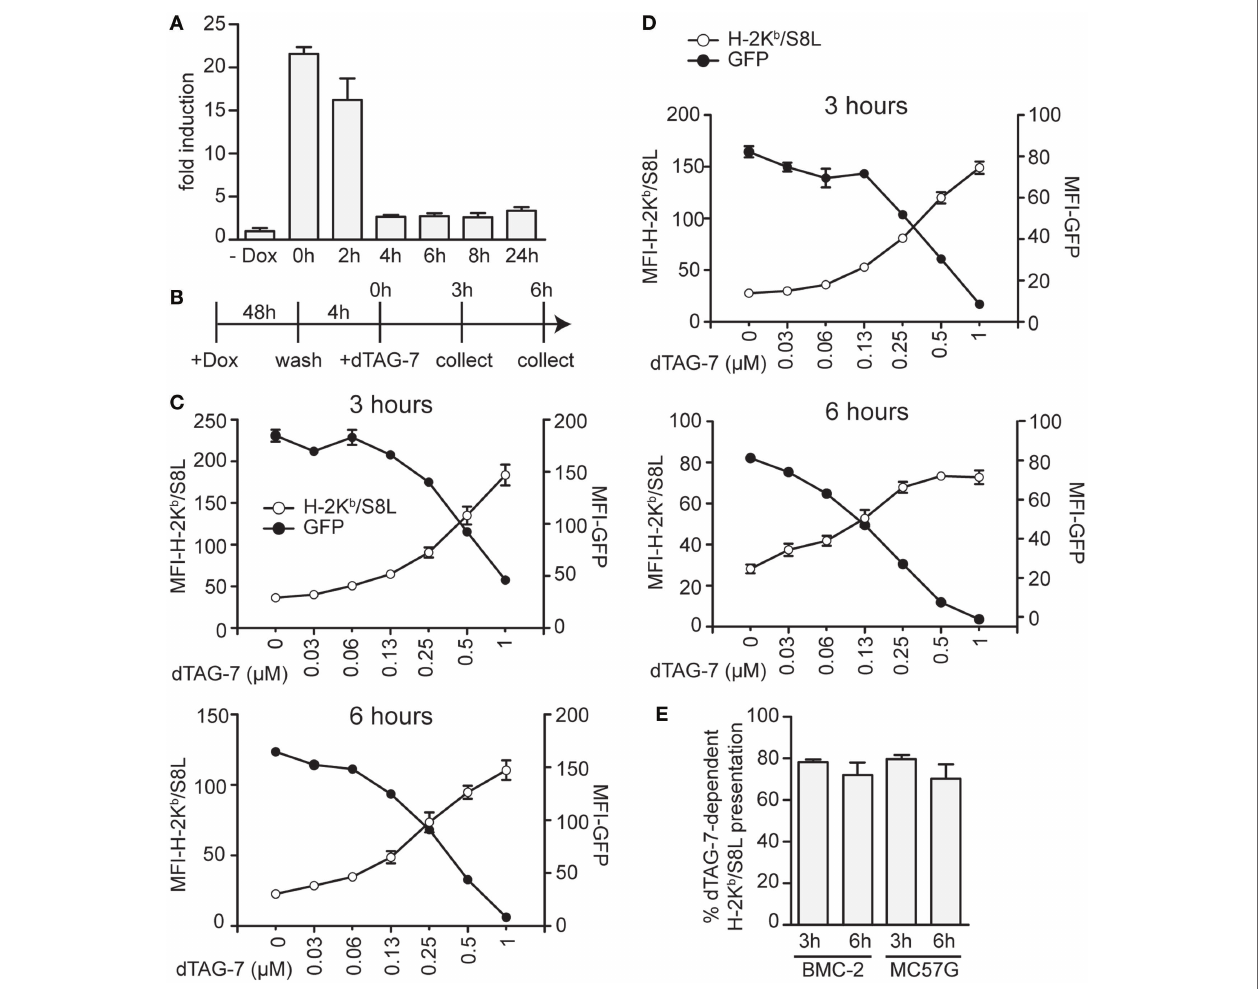
FigUre 3 | Stable antigen is the major source of MHC class I presentation upon degradation tag (dTAG)-7 treatment. (a) Real-time PCR analysis to measure the stability of GFP-S8L-F12 mRNA. BMC-2 cells were treated with 1 µg/mL doxycycline to induce GFP-S8L-F12 expression for 24 h. Then, doxycycline was washed off and mRNA stability was followed for indicated times. GFP-S8L-F12 expression is shown as fold induction compared to basal levels in the absence of doxycycline (- Dox). (B) Schematic illustration of the experiments performed in (c,D) . (c,D) GFP-S8L-F12 expression in BMC-2 (c) and MC57G cells (D) was induced by doxycycline for 48 h. Next, doxycycline was removed for 4 h, before cells were treated with 1 µM dTAG-7 for 3 or 6 h, respectively. Afterward, GFP-specific fluorescence (MFI-GFP) and MHC class I presentation of S8L (MFI-H-2K b /S8L) were quantified by flow cytometry. MFI, mean fluorescence intensity. (e) Quantification of the results shown in (c,D) from three independent experiments (for calculation details see Materials and Methods). All experiments were performed in triplicates and results are shown as mean ± SEM. Representative results from three independent experiments are